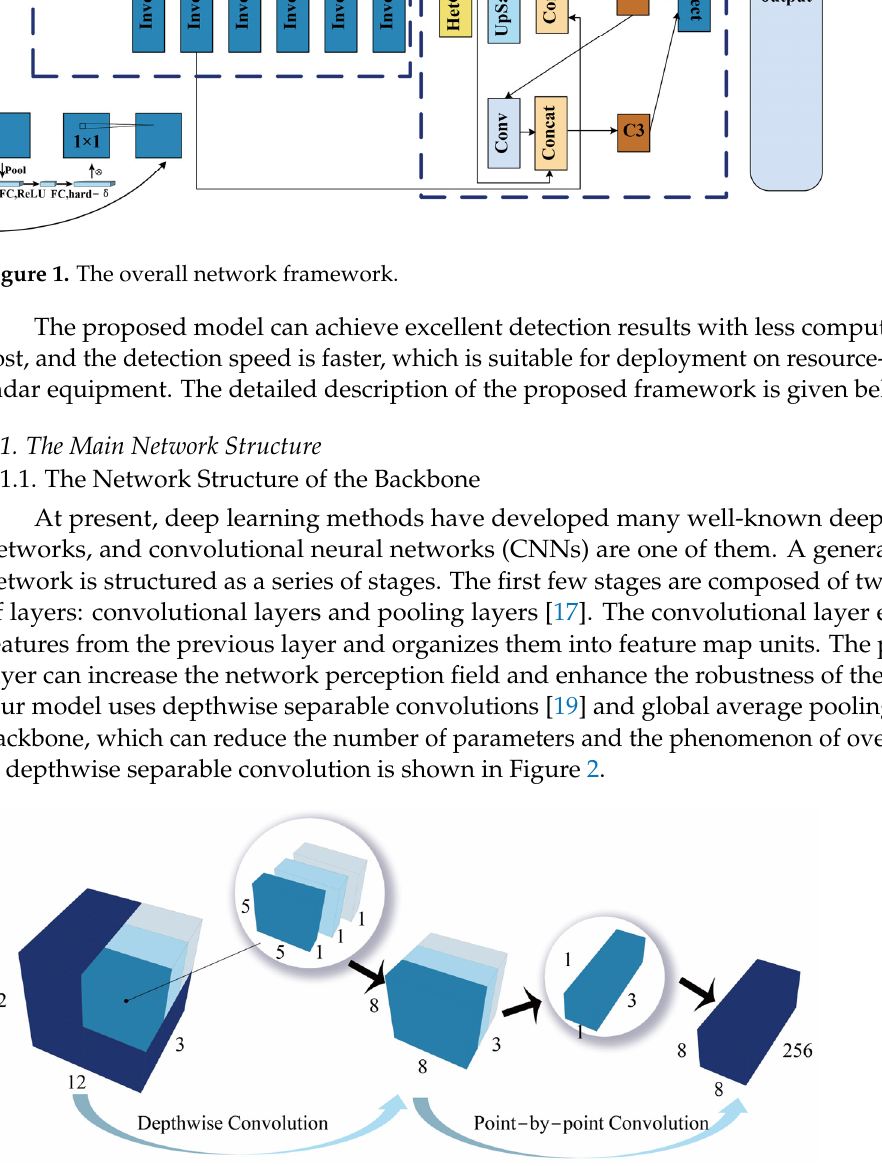
Figure 2. A depthwise separable convolution.